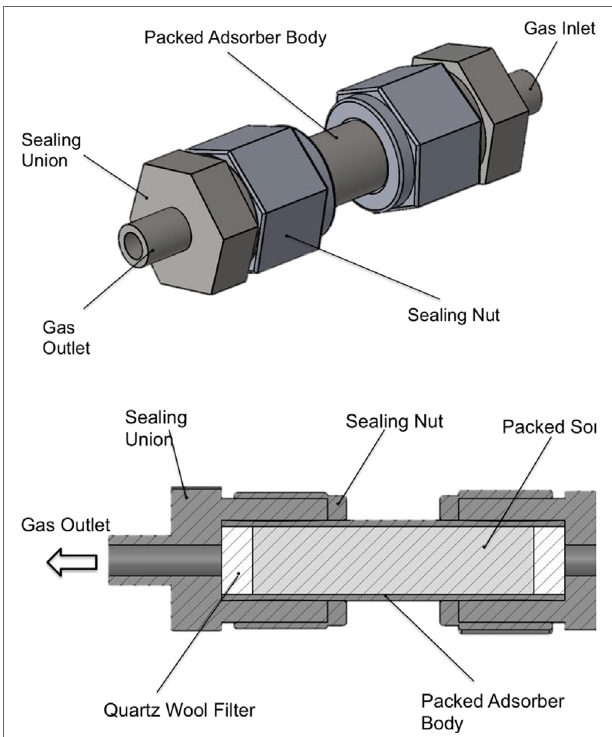
FigUre 3 | Schematic of the packed bed adsorber with cross-sectional view showing the internal layout and packing